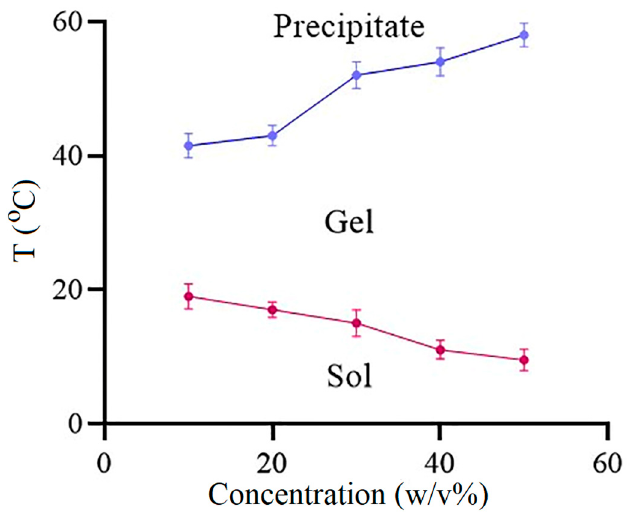
Figure 1. Sol to gel (red) and gel to precipitate (blue) phase diagram of PLGA-PEG-PLGA in water.